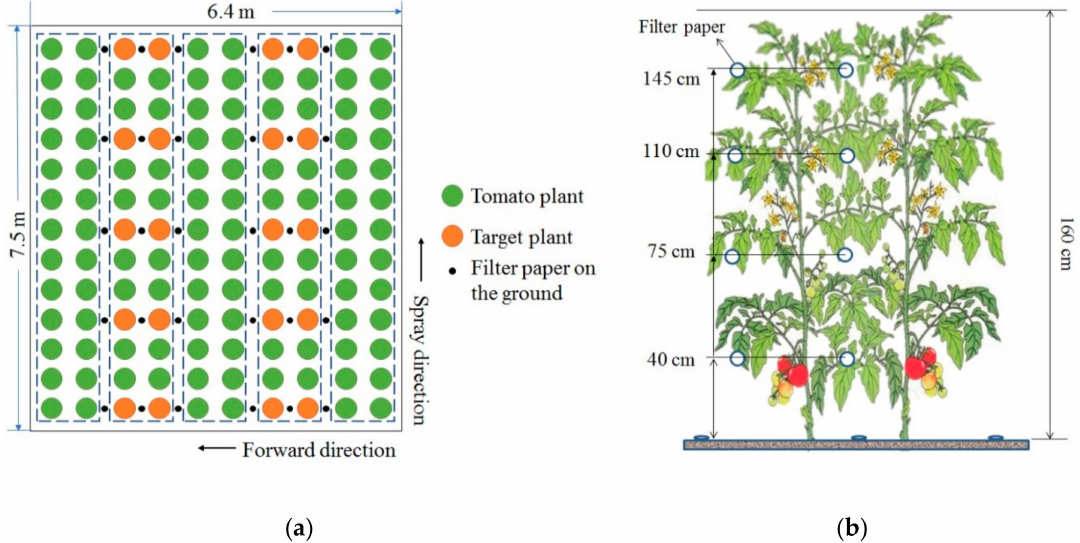
Figure 2. ( a ) The experimental layout for each treatment; ( b ) position of the filter papers within the crop and on the ground.